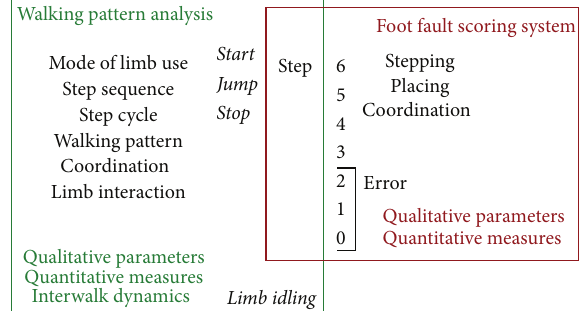
Figure 1: Proposed system of comprehensive analysis of skilled walking. Analysis of steps represents a central part of the